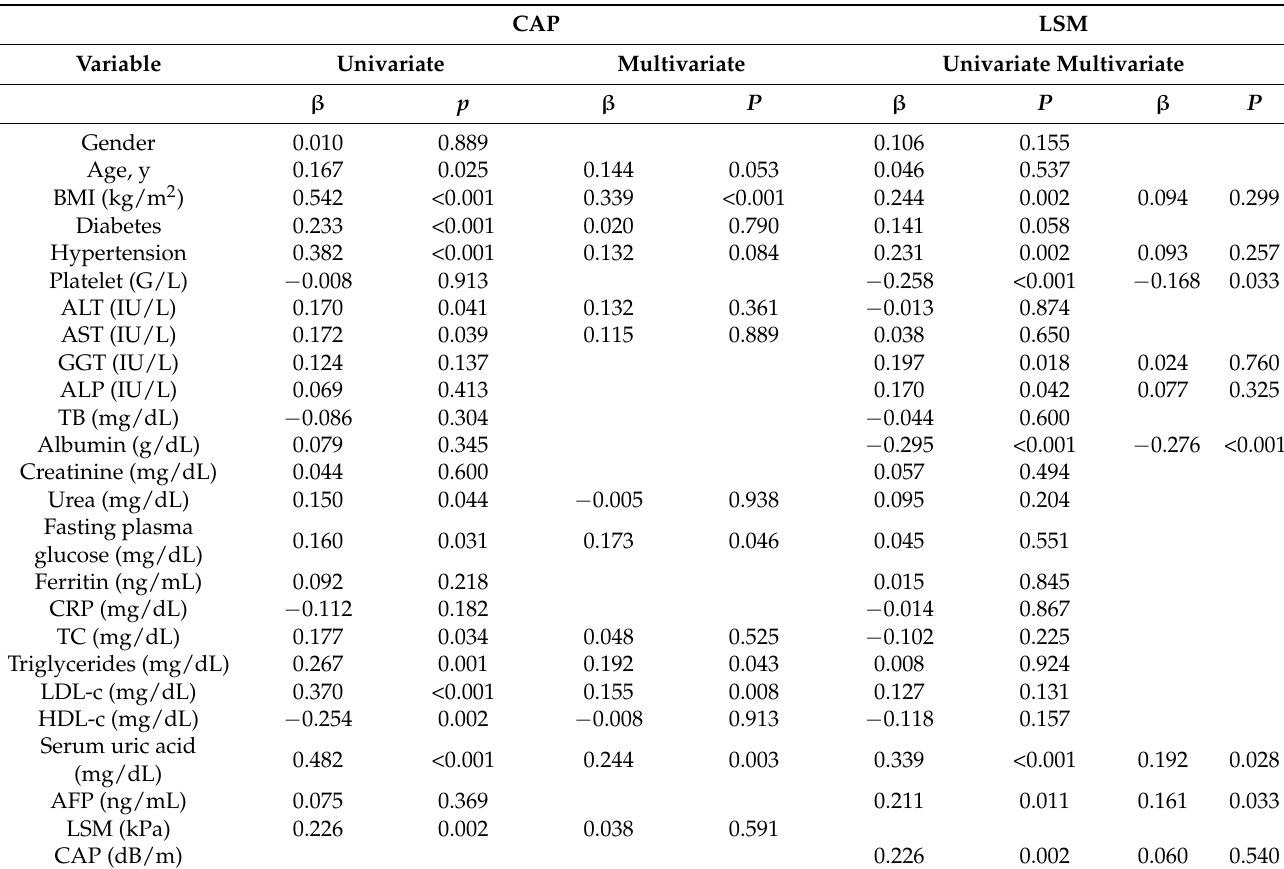
Table 2. Factors associated with controlled attenuation parameter values and liver stiffness measurement using univariate and multivariate linear regression analysis.